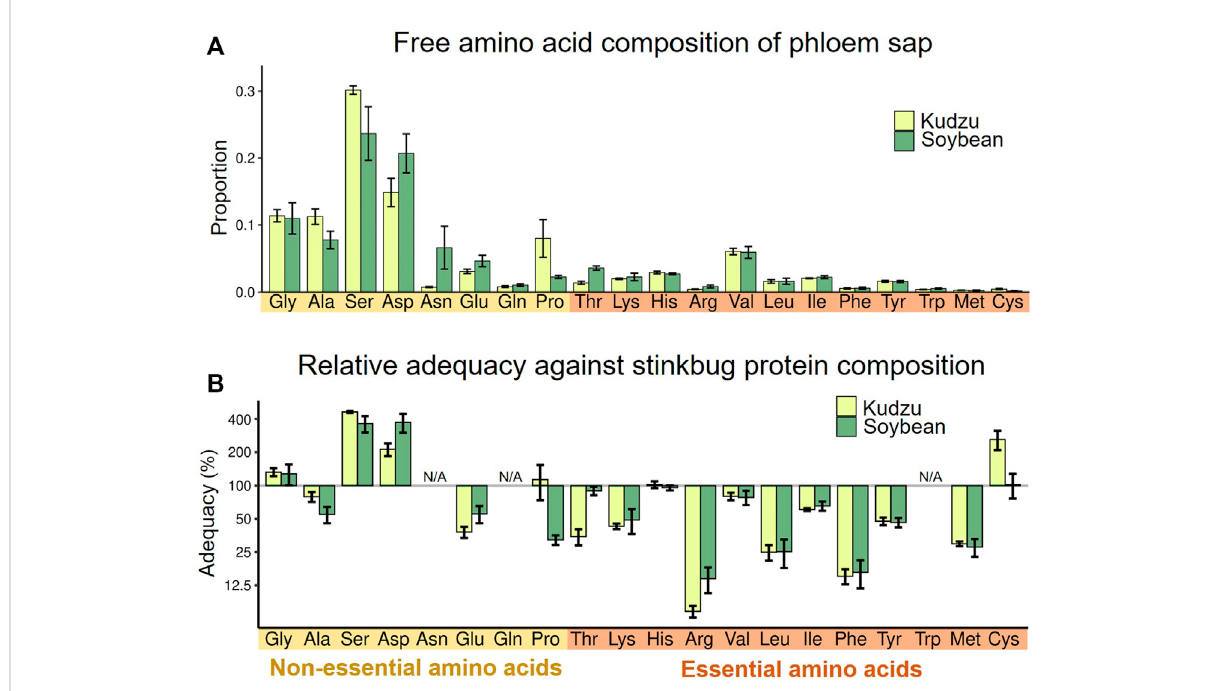
FIGURE 2 Nutritional evaluation of dietary plant sap. (A) Relative proportion of amino acids in the phloem sap of two host plants, kudzu and soybean. Means ± s.e.m are shown ( N = 6). (B) Amino acid adequacy of the phloem saps for stinkbug development. The relative adequacy was calculated againsttheproteinaminoacidcompositionofthewholebodyoffourthinstarnymphs(seealsoSupplementaryTableS1).Theamountsofasparagine and glutamine were incorporated into those of aspartate and glutamate, respectively, while tryptophan was omitted, because they were processed during protein hydrolysis (N/A). Means ± s.e.m are shown at the logarithmic scale ( N =